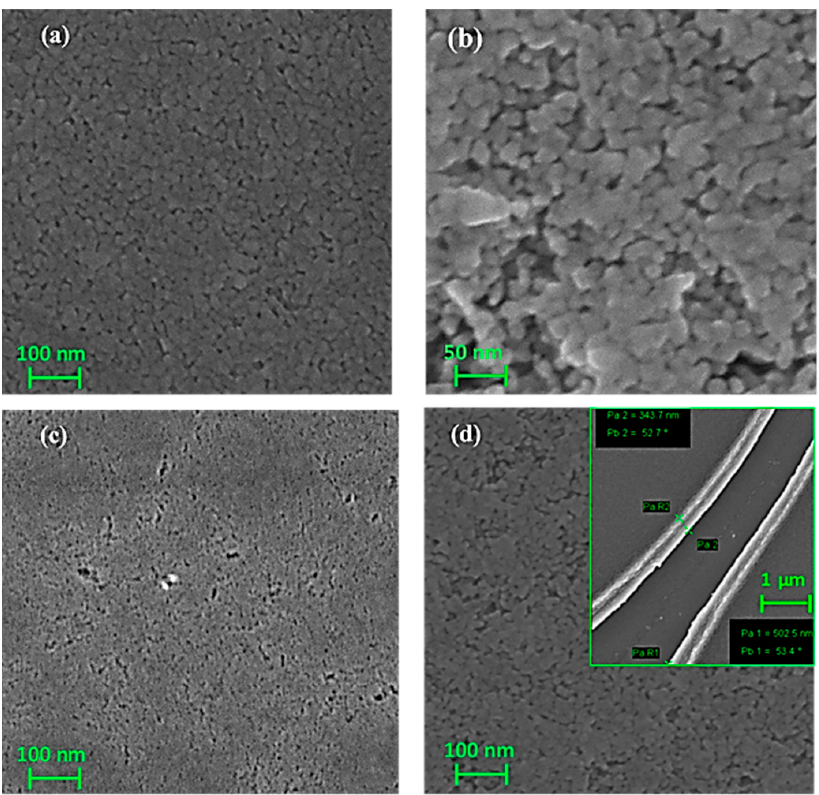
Figure 1. FE-SEM images of: ( a ) undoped TiO 2 ( b ): 2% N dopedTiO 2 ( c ): 2% Y doped TiO 2 and ( d ): 2% Y-N codoped TiO 2 thin films annealed at 400 °C. Y-N codoped TiO 2 thin films annealed at 400 ◦